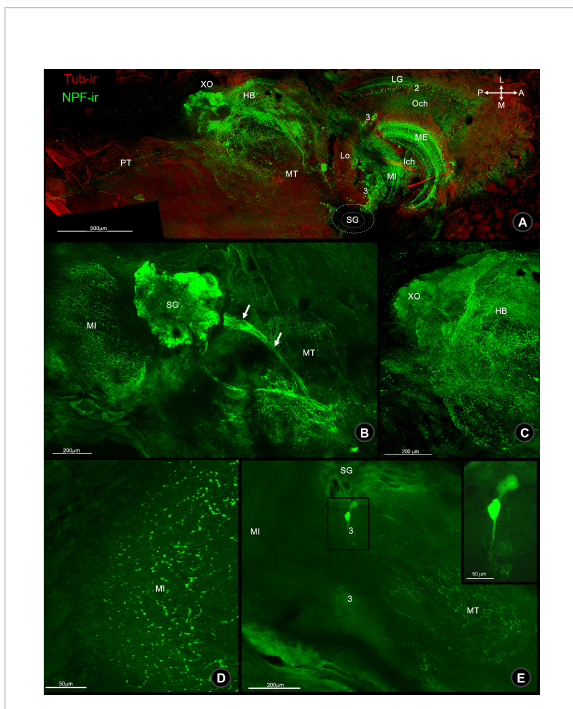
FIGURE 1 Wholemount immuno fl uorescence photographs of Macro -NPF- ir in the bi-section of the mud crab ’ s ES. (A) Low-magni fi cation overview image of ES revealed the localization of Macro -NPF-ir in the neuropils and neuronal clusters. NPF-ir showed in SG and its connecting fi bers to XO (arrows) (B) the fi ber network of HB and XO (C) , nerve fi ber punctuates forming as medullary interna (MI) (D) , and medium neurons in cluster 3 (E) . ( LG , laminar ganglionaris; Och , outer optic chiasm; ME , medullar externa; Ich , inner optic chiasm; MI , medullar interna; Lo , lobar; SG , sinus gland; MT , medullar terminalis; HB , hemiellipsoid body; XO , X- organ; PT , protocerebral tract).